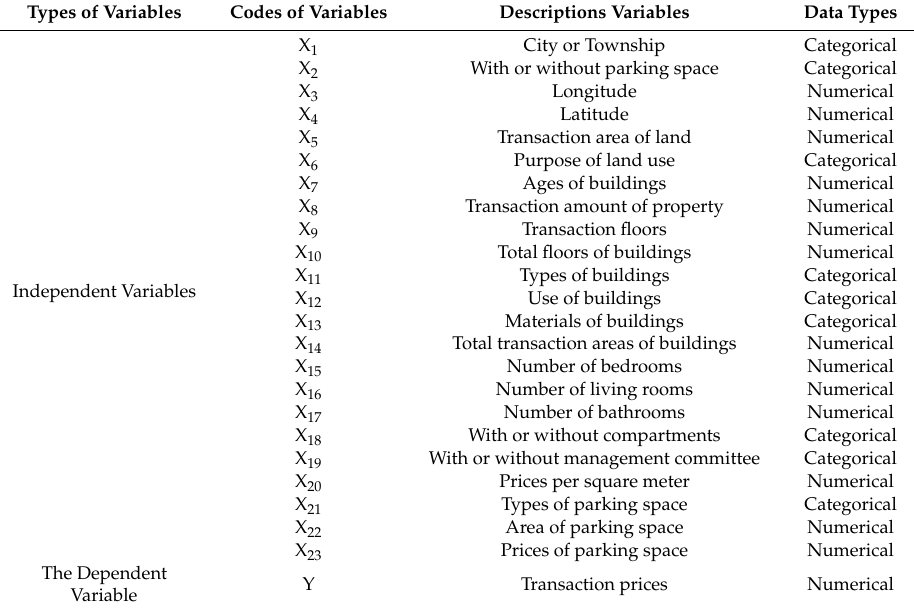
Table 1. Depictions of variables.